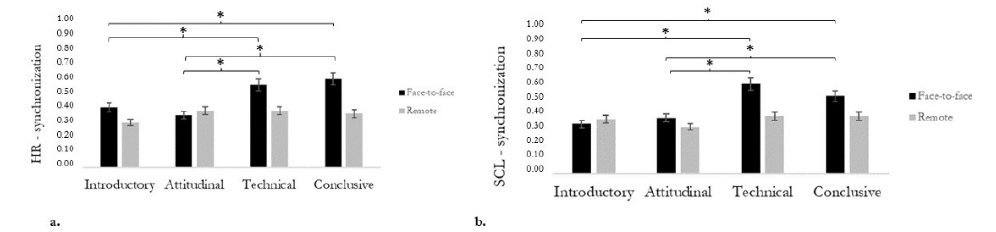
Figure 6. Heart rate (HR) and skin conductance level (SCL) significant results. ( a ) Bar graph shows the difference in HR considering the Condition*Interview interaction. Bars represent ± 1 SE. Stars mark statistically significant pairwise comparisons. ( b ) Bar graph shows the difference in SCL considering the Condition*Interview interaction. Bars represent ± 1 SE. Stars mark statistically significant pairwise comparisons.